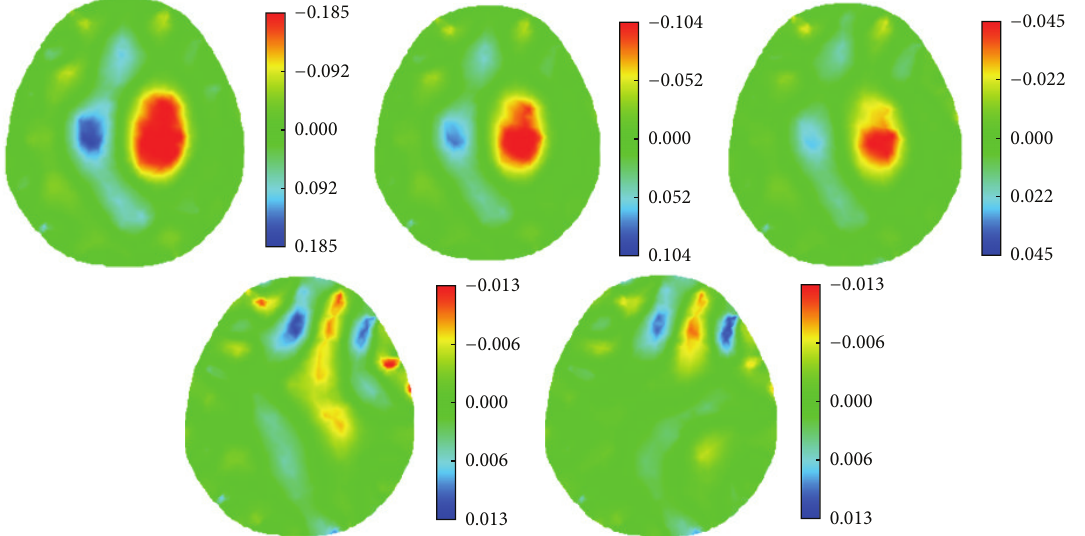
Figure 21: SEIT reconstructions of agar cylinders with radii of 2, 1.5, 1, 0.5, and 0.25 cm to simulate hemorrhagic stroke lesions of different sizes.